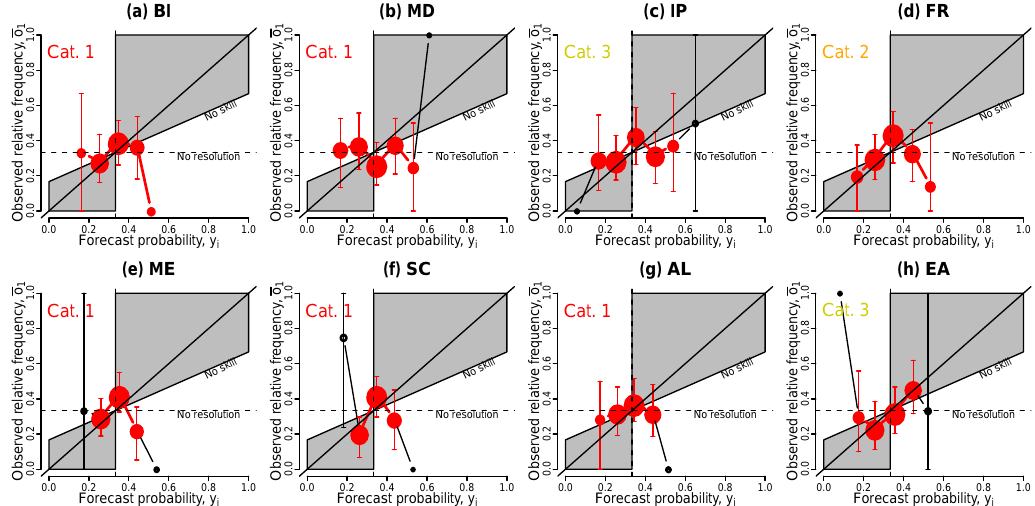
Figure 15. Reliability diagrams for low summer precipitation, defined as seasonal JJA averages in the lower tercile. See the caption of Fig. 13 for technical details.